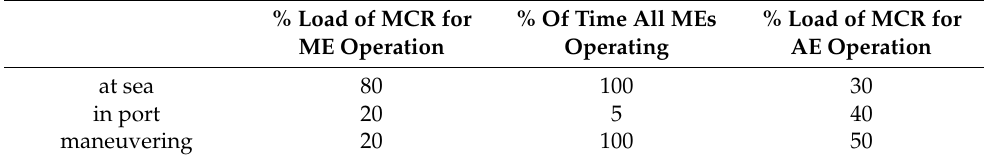
Table 5. Main and auxiliary engines power demands at different operation profiles. % Load of MCR